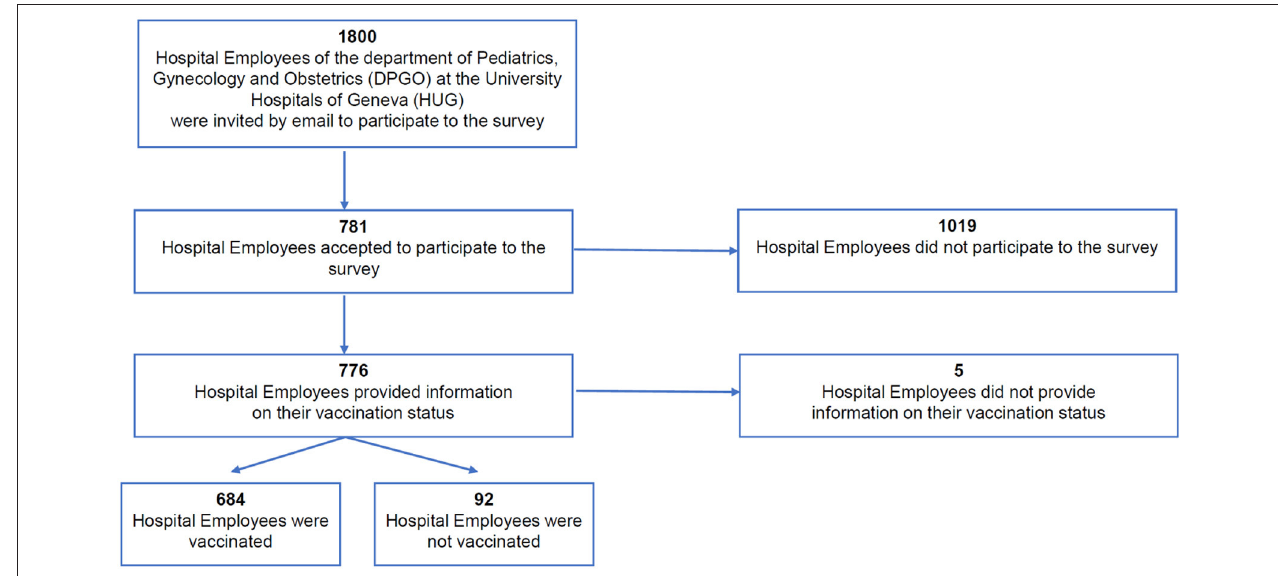
FIGURE 1 | Flowchart of the study